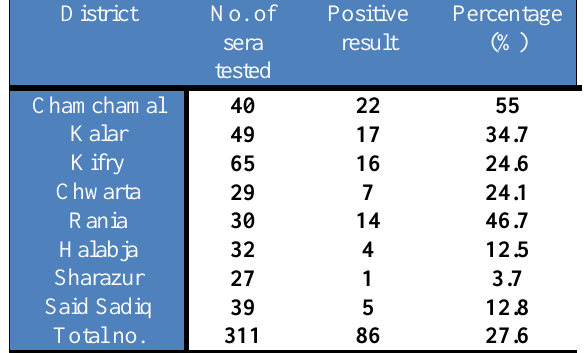
Table, 2: Percentage of infection of sheep and goat brucellosis by using iELISA according to districts.